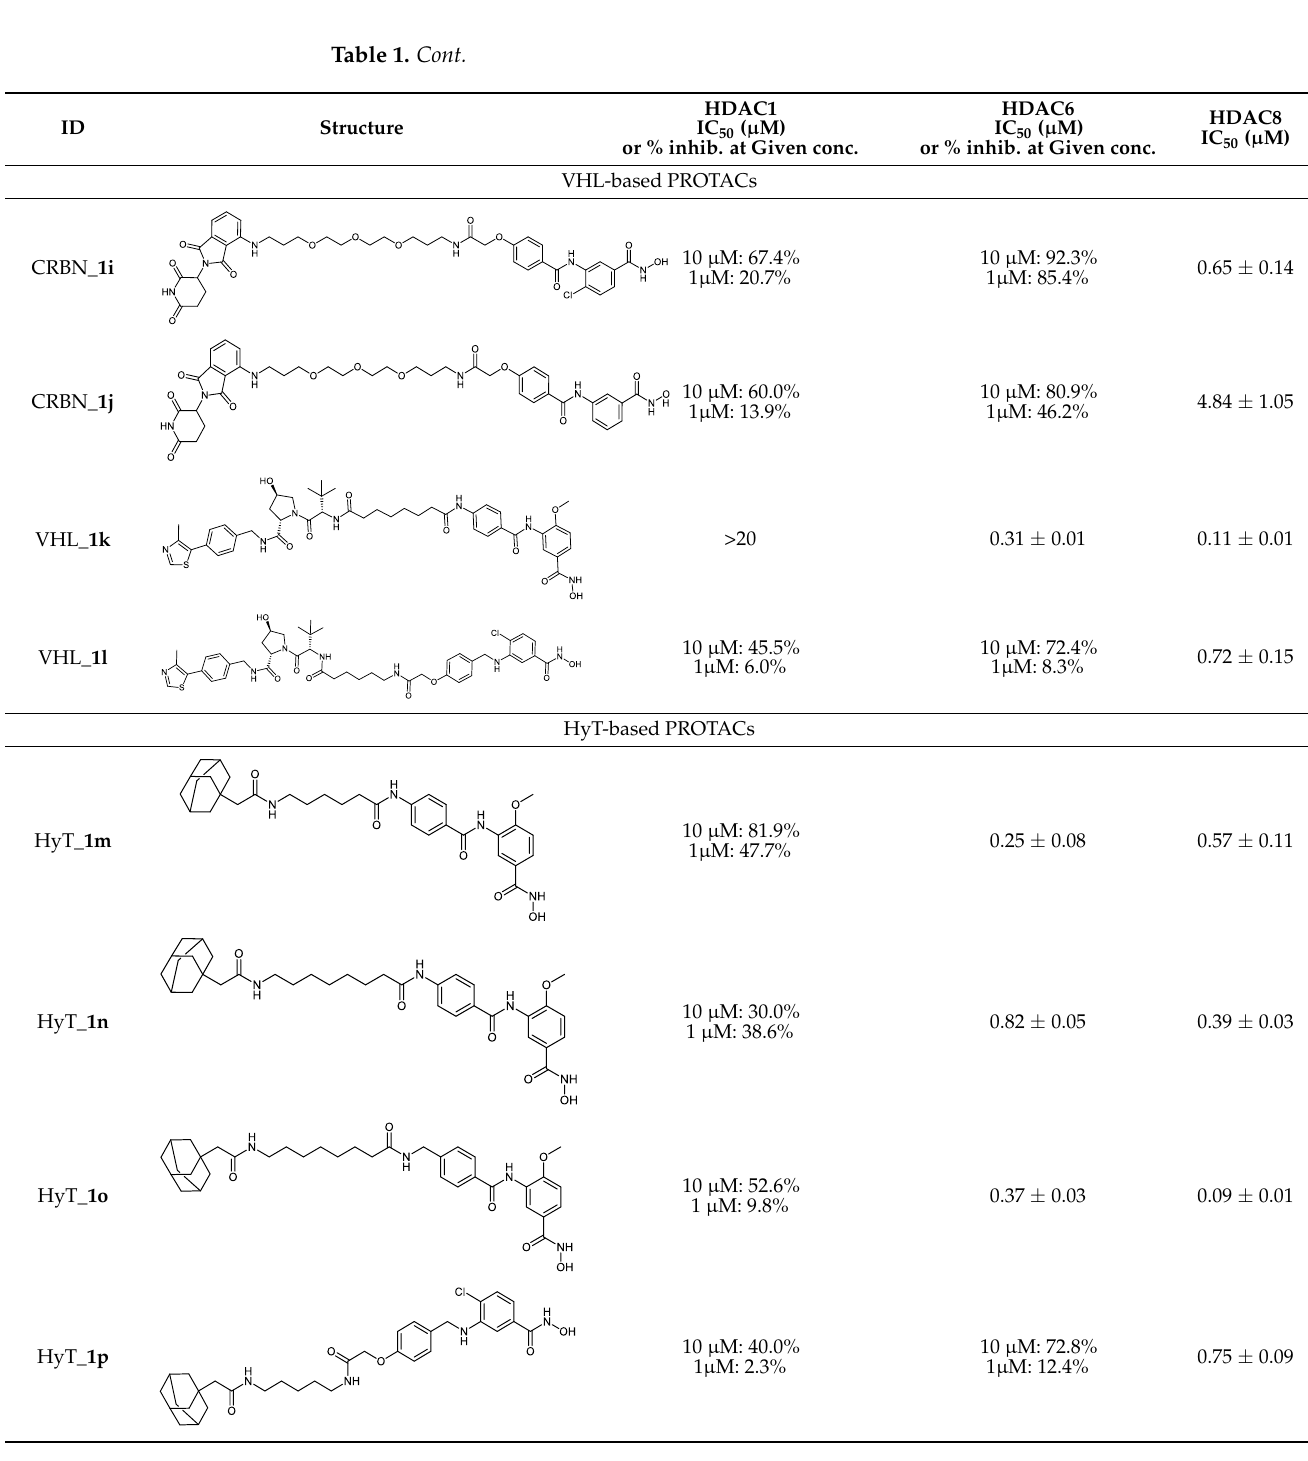
Table 2. IC 50 values for benzhydroxamate-based HADC inhibitors underlying PROTAC develop- ment